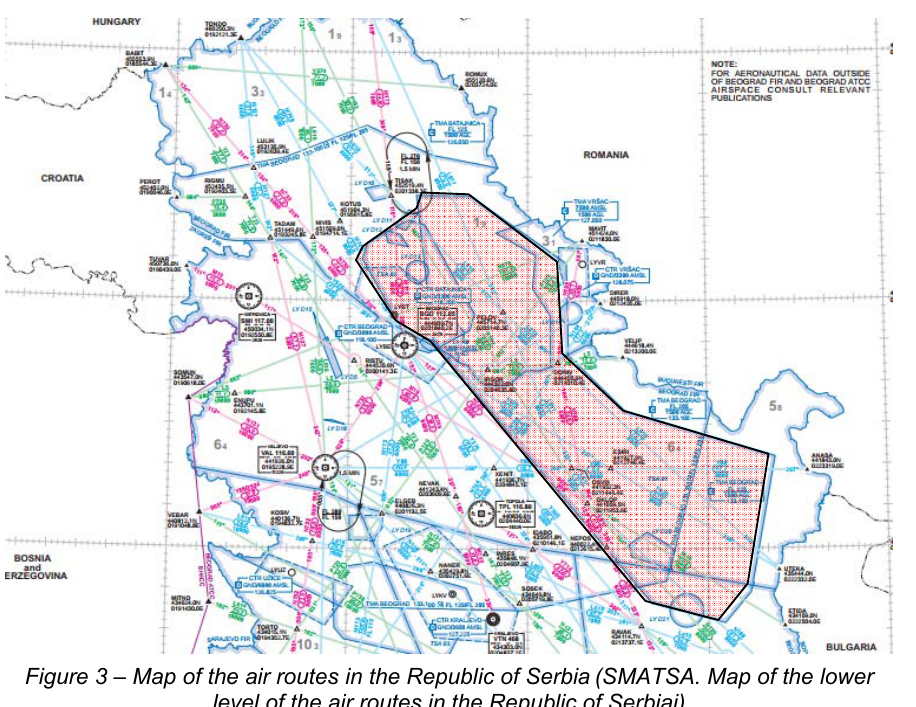
Figure 3 – Map of the air routes in the Republic of Serbia (SMATSA. Map of the lower level of the air routes in the Republic of